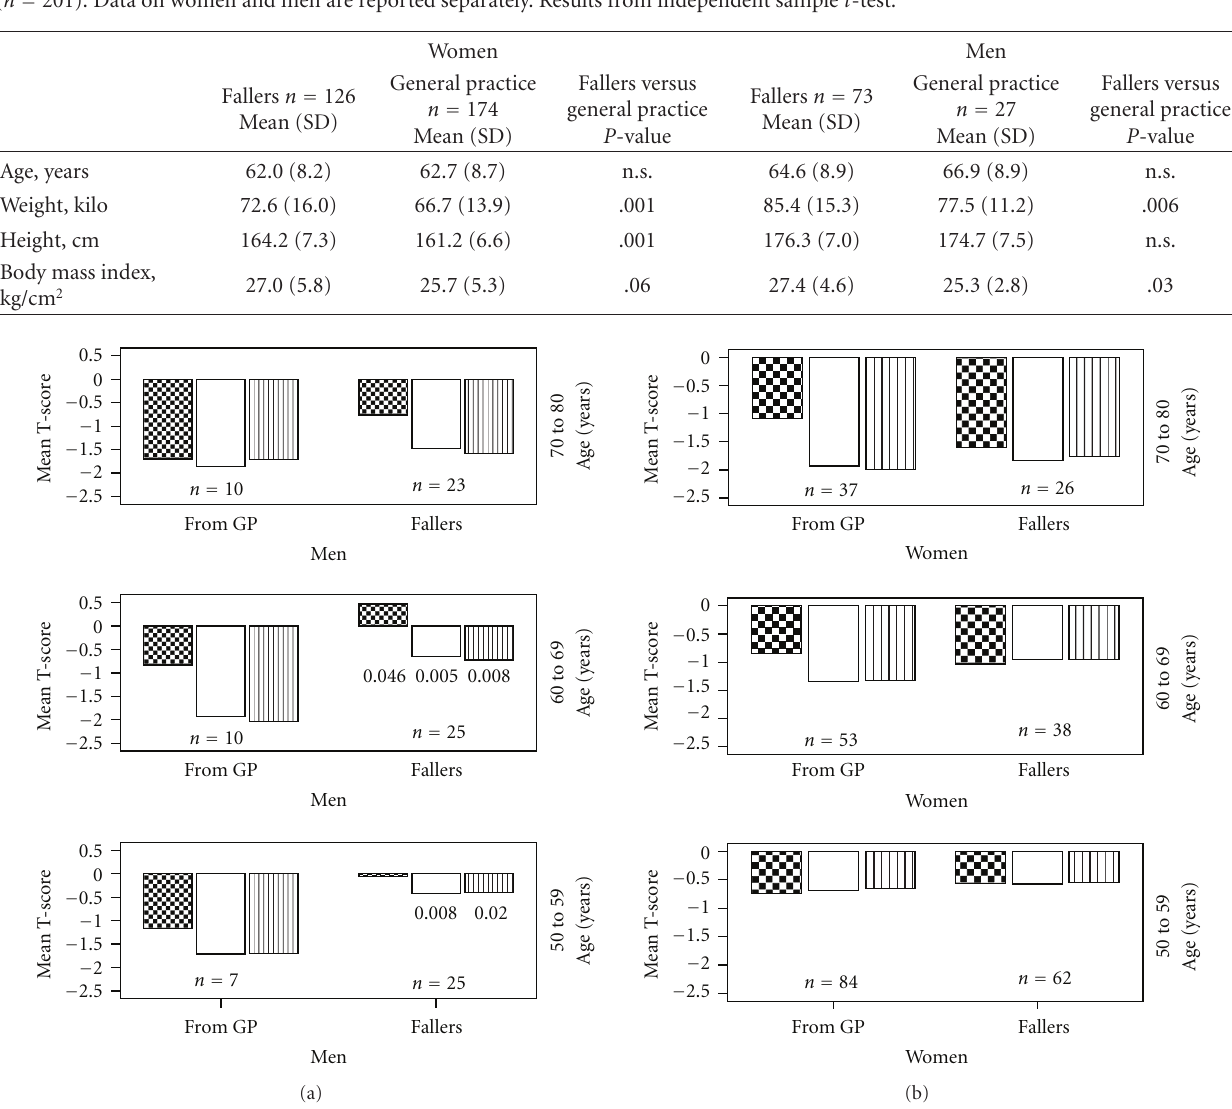
Figure 2: Mean T-score measured among fallers ( n = 199) compared to patients referred from general practice ( n = 201) by patient age. Data on men and women are reported separately. Significant di ff erences are marked with P -values. Chequered bars: lumbar spine; empty bars: left femoral neck; bars with vertical stripes: right femoral